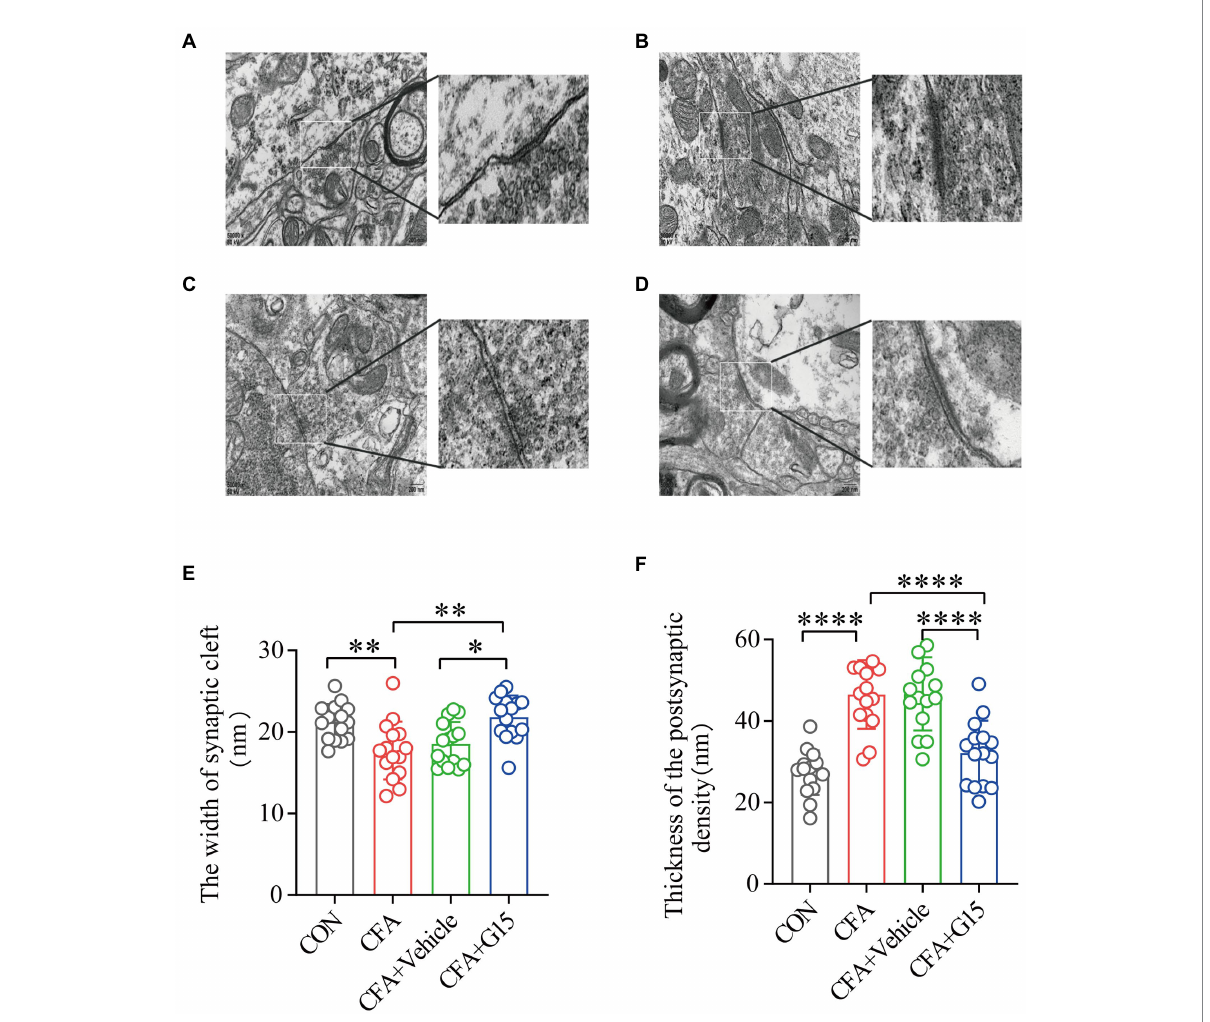
FIGURE 7 Synaptic structure of the RVM neurons in each group. (A) CON group; (B) CFA group; (C) CFA + Vehicle group; (D) CFA + G15 group. ( E ) The width of the synaptic cleft was decreased in the CFA group and CFA + Vehicle group compared with the CON group. There was no significant difference between the CFA group and the CFA + Vehicle group. ( F ) The thickness of PSD was significantly increased in the CFA group and CFA + Vehicle group compared with the CON group. There was no significant difference between the CFA group and the CFA + Vehicle group. Data represent the mean ± SD. Statistical analysis was performed using one-way ANOVA followed by the Tukey post hoc test for multiple group comparisons. * p < 0.05, ** p < 0.01, **** p < 0.0001. n = 3 per